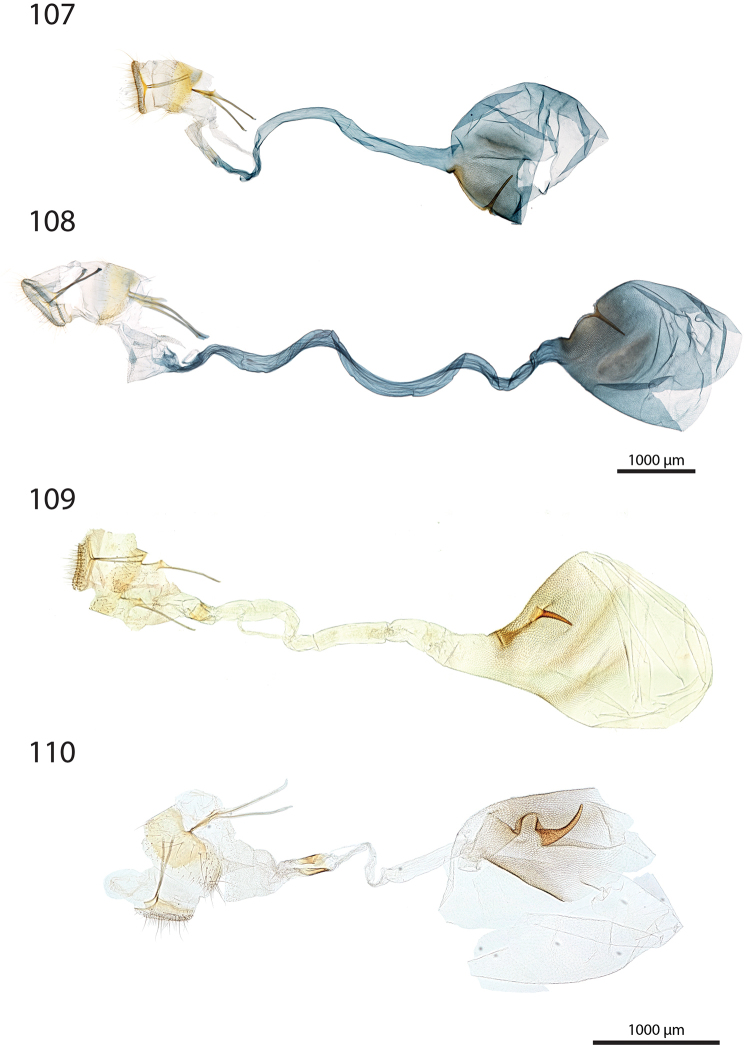
Female genitalia features of Hoploscopa. 107Hoploscopa
astrapias, TL23 ♀ 108Hoploscopa
anamesa, TL718 ♀ 109Hoploscopa
subvariegata, lectotype, Pyralidae Brit. Mus. Slide N° BMNH20254 ♀ 110Hoploscopa
triangulifera, holotype, Pyralidae Brit. Mus. Slide N° BMNH20256 ♀.